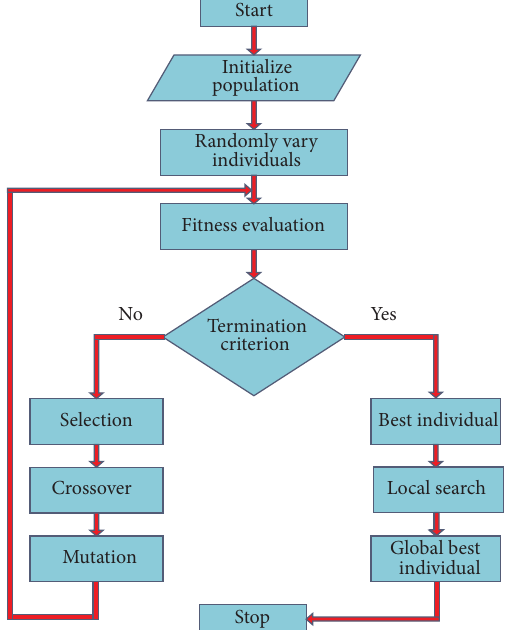
Figure 2: Flow diagram for hybrid GA-PS and